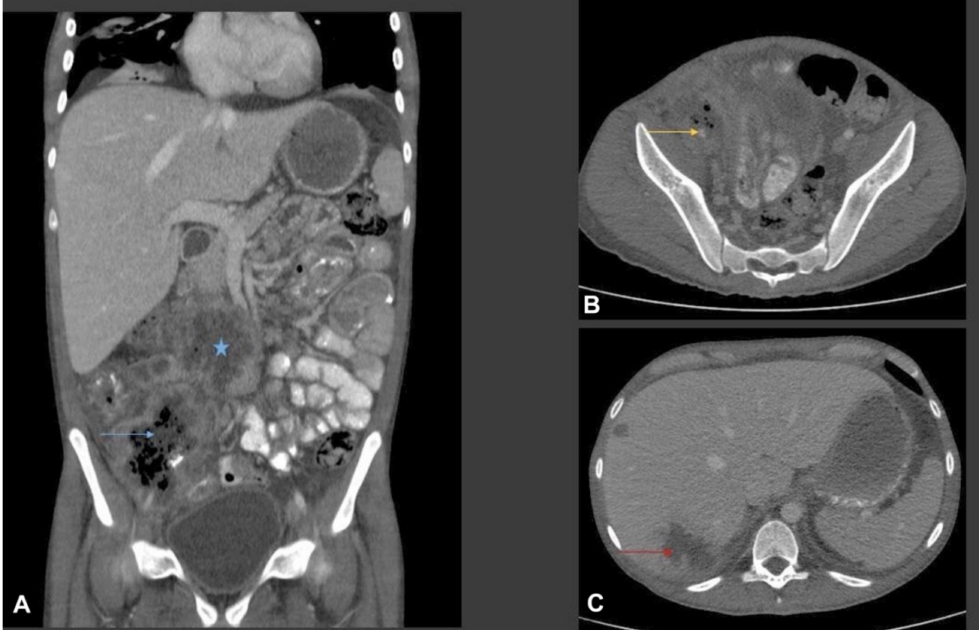
Figure 1. Multiplanar CT scan of abdomen with oral and intravenous contrast. ( A ) Coronal CT image shows a multispatial ill-defined low-attenuation ring enhancing collection in the root of the mesentery (star) and in the right iliac fossa. The right iliac fossa collection shows thick irregular rim enhancement with central bubbly air lucency (blue arrow). Bowel loops are adherent to the collections. There is marked inflammatory fat stranding noted in the right iliac fossa and right side of the pelvic cavity. Small volume ascites. ( B ) Axial CT image from the right iliac fossa and pelvis shows marked phlegmonous soft tissue lesion with fat stranding. The phlegmonous inflammatory mass is encasing the right external iliac artery which is small and irregular in calibre (yellow arrow). ( C ) Axial images from the liver show multifocal ill-defined low-attenuation liver lesions of variable size (two of them shown in this image). The largest was seen in the subcapsular liver in the segment VII and shows surround oedema, suggestive of liver abscess (red